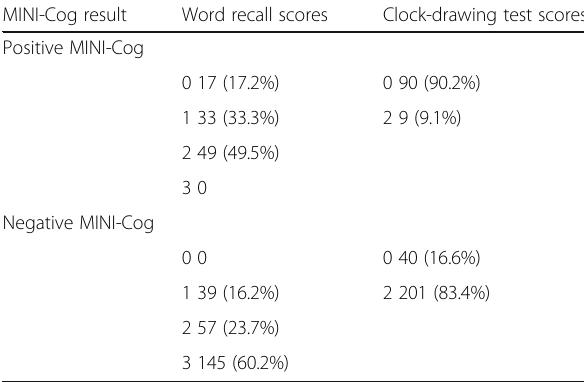
Table 2 Scores of word recall and clock-drawing test MINI-Cog